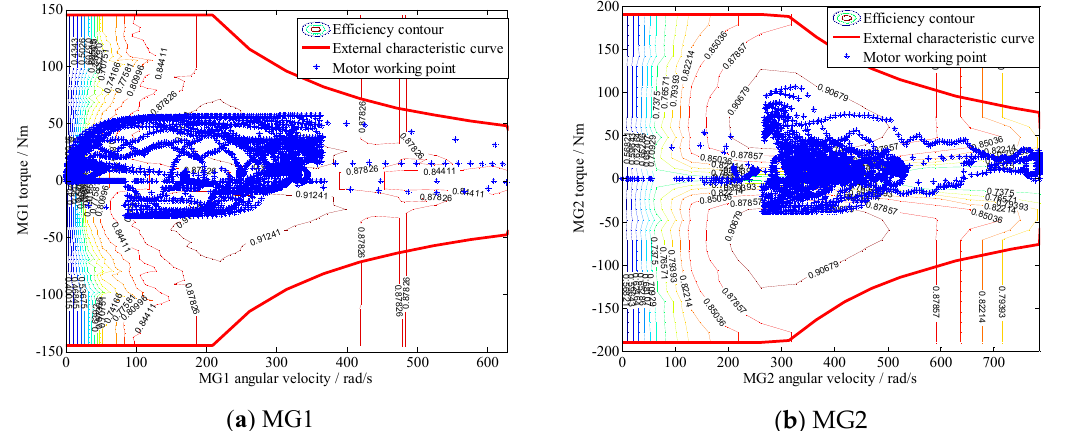
Figure 8. Motor working points of dual motor coupling configuration.